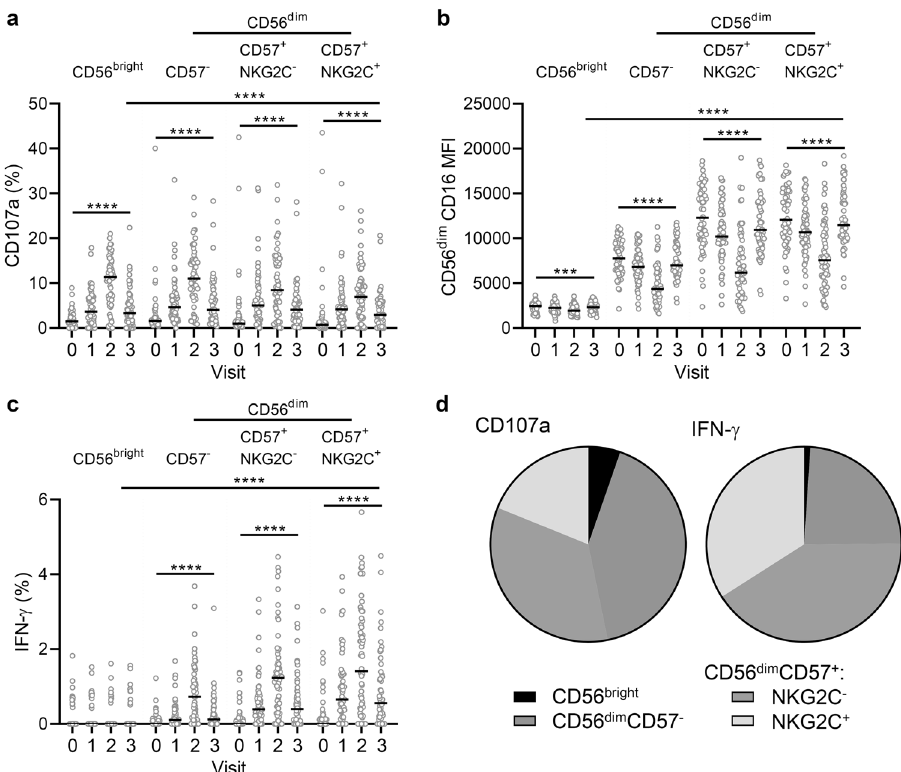
Fig. 3 Antibody-dependent responses of different NK cells subsets. NK cells from a single unvaccinated donor were cultured with EBOV GP in the presence of serum collected from pre-vaccination (visit 0), on day 29, 57, or 85 post-dose 1 (visit 1), 14 days post-dose 2 (visit 2) and 180 days post-dose 2 (visit 3) and analysed by fl ow cytometry for CD107a ( a ), CD16 MFI ( b ), and IFN- γ ( c ) expression according to NK cell differentiation subset. Data are pooled for all three vaccine groups (see Table 1 for n ). Data points are shown with bars representing median values. The proportion of total NK cell CD107a and IFN- γ expression (using visit 2 serum) attributed to each subset is shown as a pie chart ( d ), with each slice representing the median (see Table 1 for number of participants). Comparisons across visits were performed using one-way ANOVA mixed effects analysis with Geisser – Greenhouse correction and comparison between subsets was performed using and one-way ANOVA with Dunn ’ s correction. **** p <